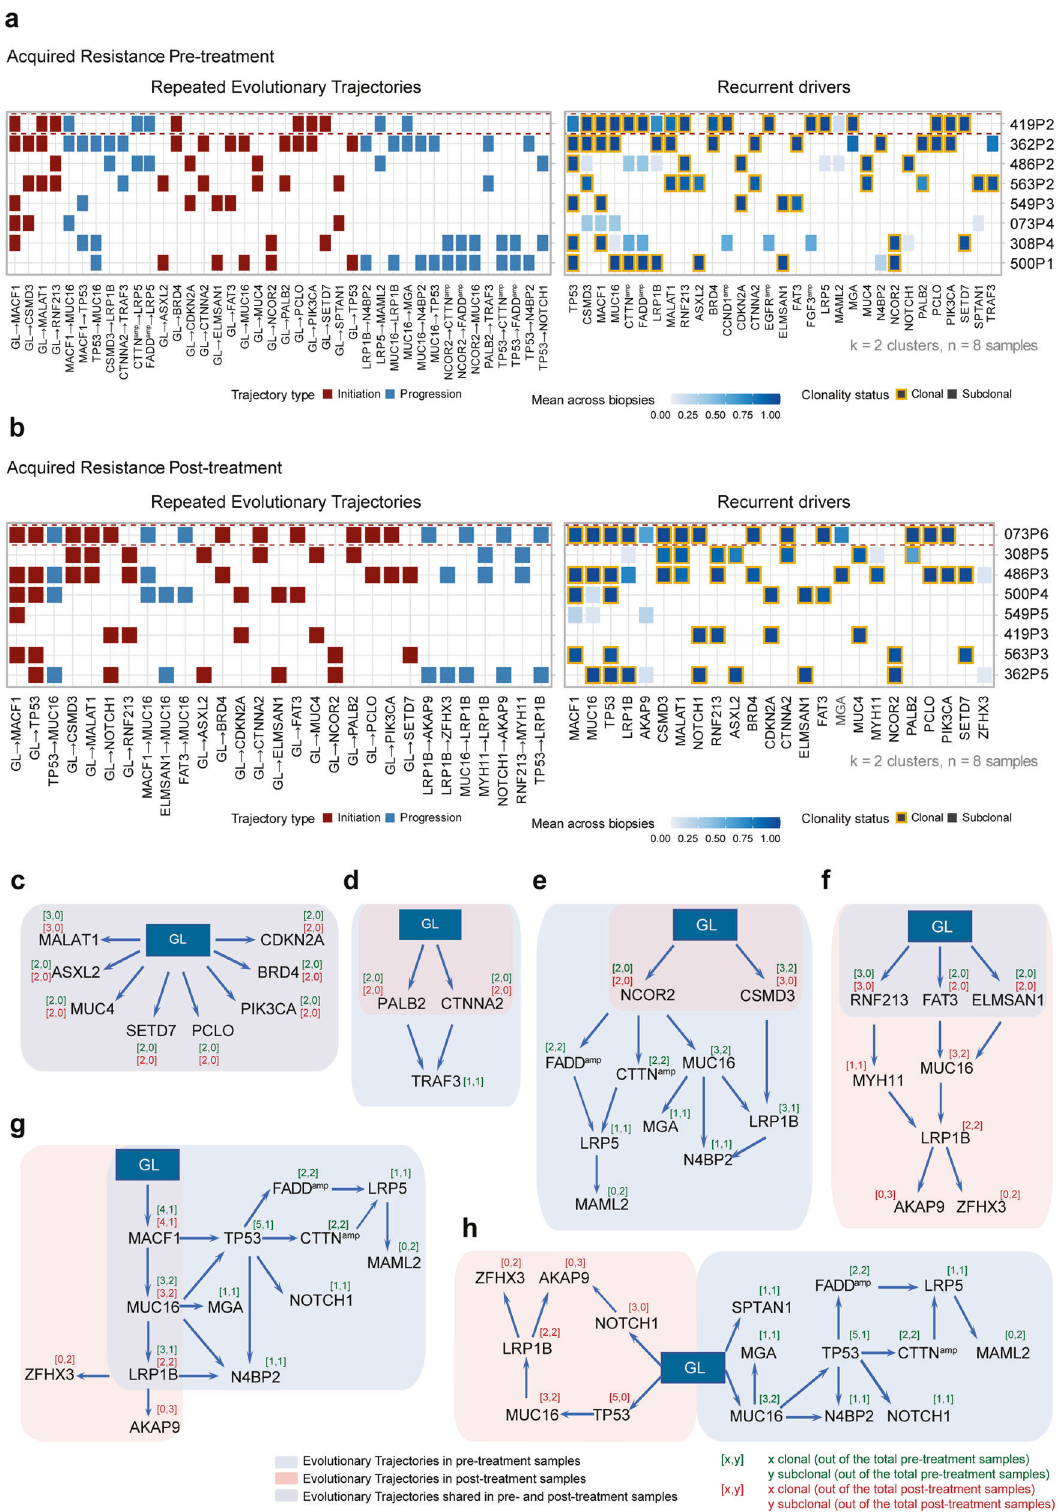
development of acquired drug resistance. Previous research has reported that the NOTCH1 mutation is a predictive factor for anti- CD20 monoclonal antibody resistance in chronic lymphocytic leukemia in a randomized chemo-immune therapy phase III trial (COMPLEMENT 1).